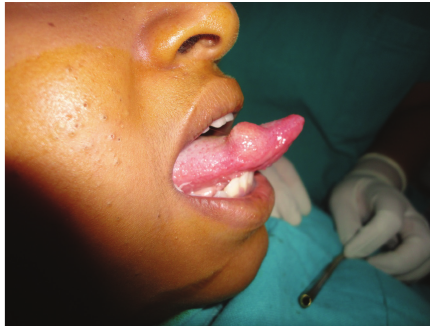
Figure 1: Asymptomatic nodule over right anterolateral side of tongue.